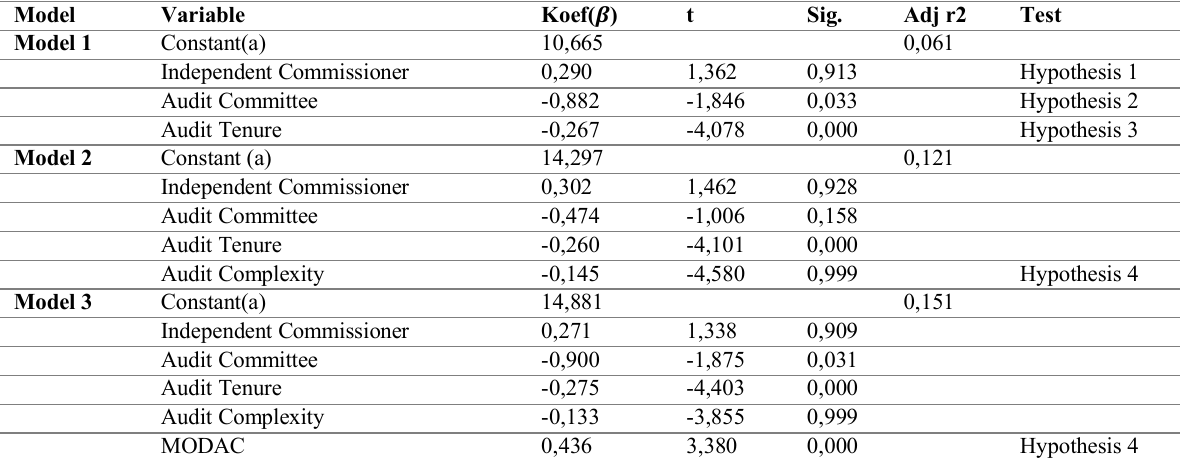
Table 2 : Results of Regression